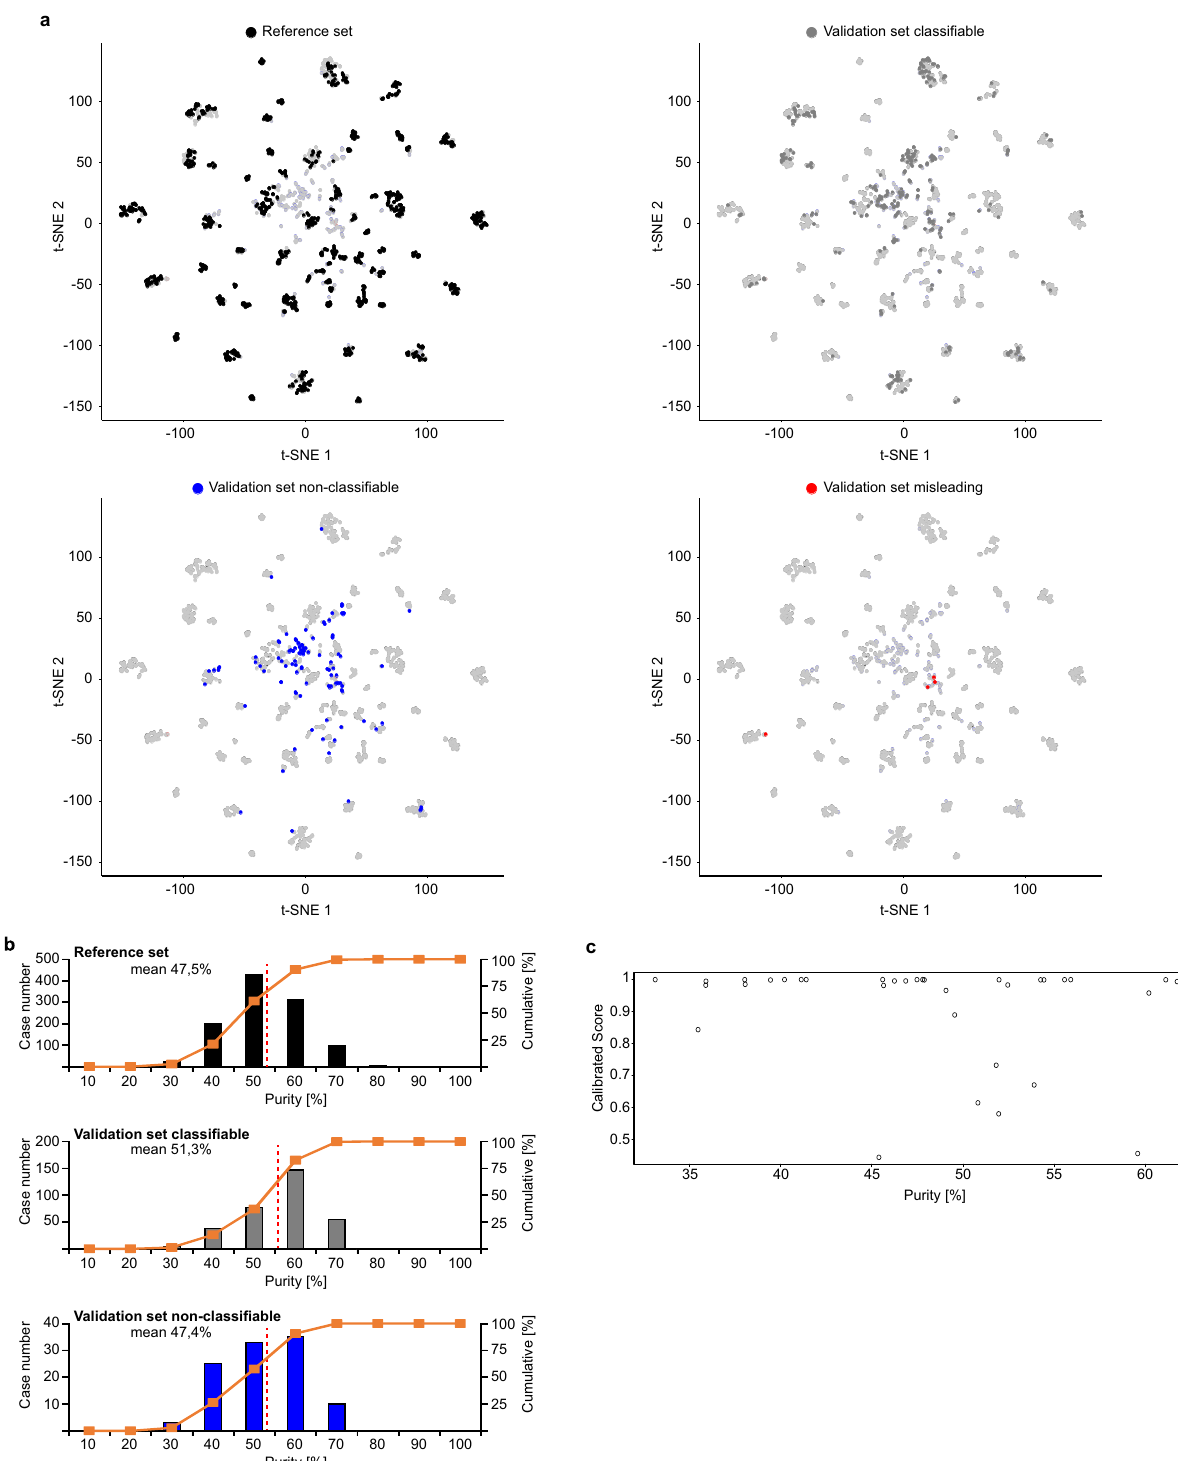
Fig. 5 Impact of tumour cell purity on classi fi er performance. a Unsupervised clustering of the combined reference ( n = 1077) and diagnostic cohort ( n = 428) using t-SNE dimensionality reduction. The reference set is indicated in the upper left plot. The diagnostic samples coded as classi fi able ( n = 318, grey dots; upper right plot), non-classi fi able ( n = 106, blue dots; lower left plot) and misleading ( n = 4, red dots; lower right plot). The classi fi able cases show high overlap with the reference cases. The non-classi fi able cases frequently fall in the periphery of or are completely separate from the reference samples. b Tumour cell purity histogram plots of the reference set and the validation set subdivided into classi fi able and non-classi fi able cases. The mean value is indicated as dashed red line and provided as number [%]. c Tumour cell purity plotted against calibrated score for conventional osteosarcoma cases of the validation